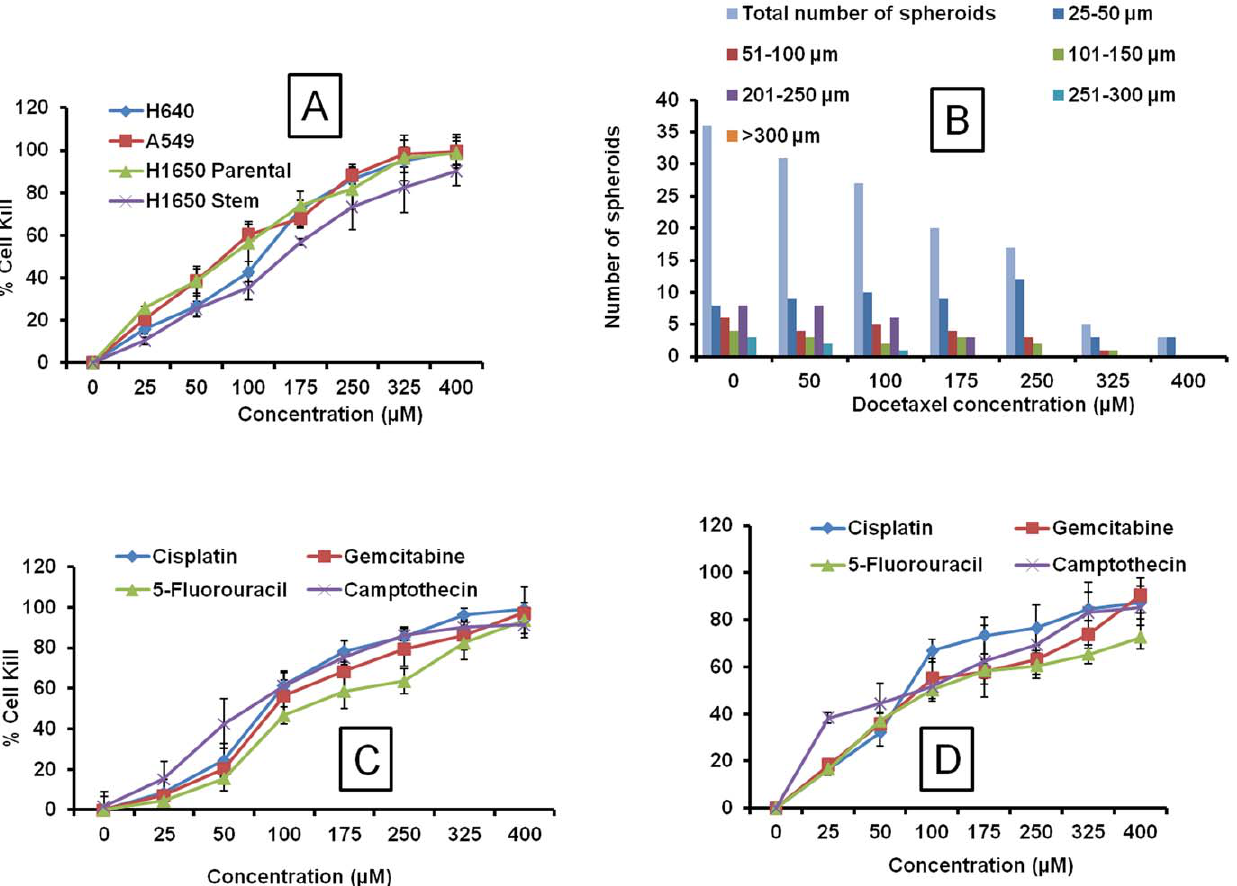
Figure 4. Effect of anticancer agents in 3D system. A) Effect of Docetaxel on H460, A549, H1650 parental and stem lung tumor cells in 3D alginate scaffold system. B) Spheroid size distribution at the various concentrations of Docetaxel on H460 lung cells in 3D alginate scaffold system. Cytotoxicity of anticancer drugs (Cisplatin, Gemcitabine, 5-Fluorouracil and Camptothecin) in 3D alginate scaffold systems on C) H460 and D) A549 lung cancer cells. Each data point is represented as mean 6 sem